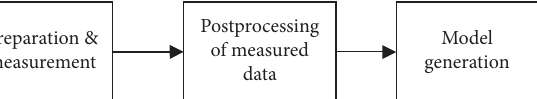
Figure 4: Basic steps for